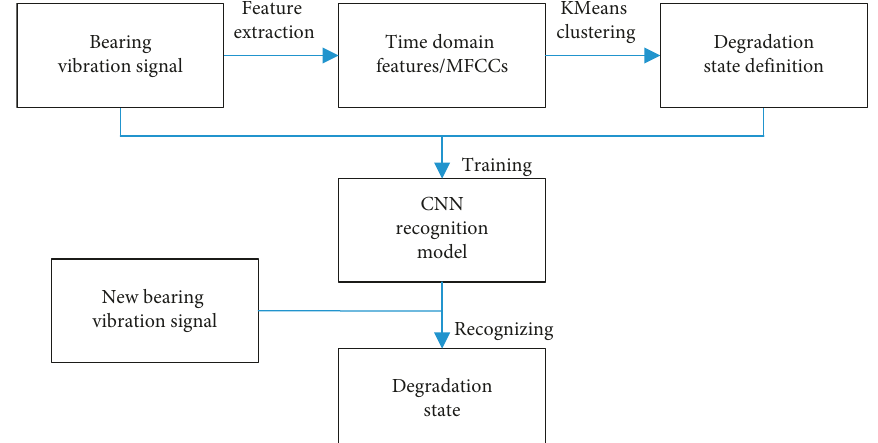
Figure 3: Architecture of the proposed method.